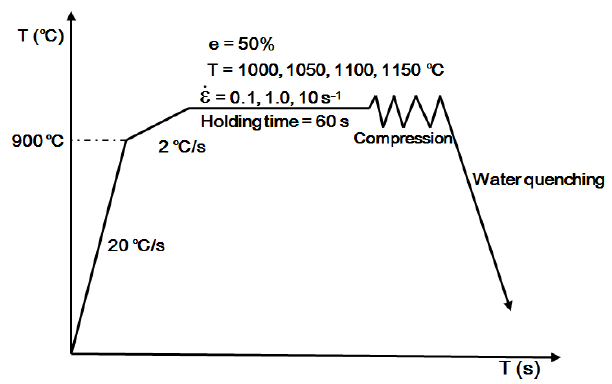
Figure 2. Schematic diagram of the hot compression temperature – time curve.